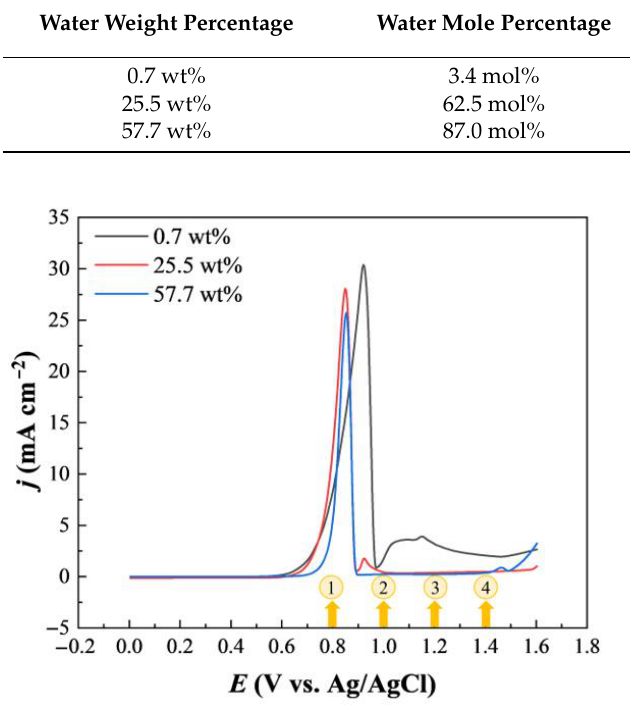
Figure 2. Linear sweep voltammograms of Au electrode in ethaline with different water contents (black line: 0.7 wt%; red line: 25.5 wt%; blue line: 57.7 wt%). Scan rate: 5 mV/s. Yellow circled 1, 2, 3, 4 represent 0.8 V, 1 V, 1.2 V, 1.4 V, respectively.